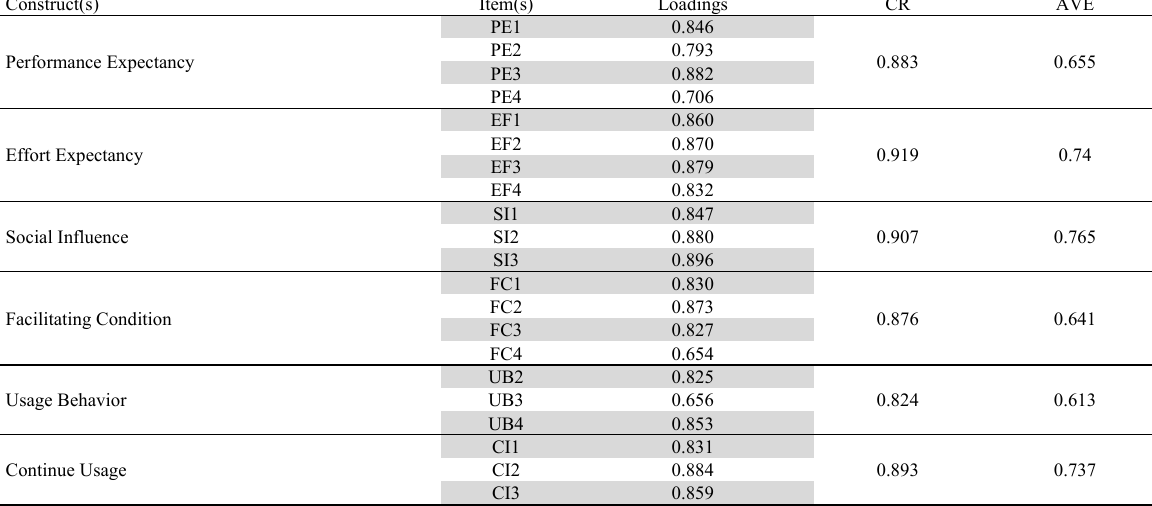
The result of construct validity and reliability